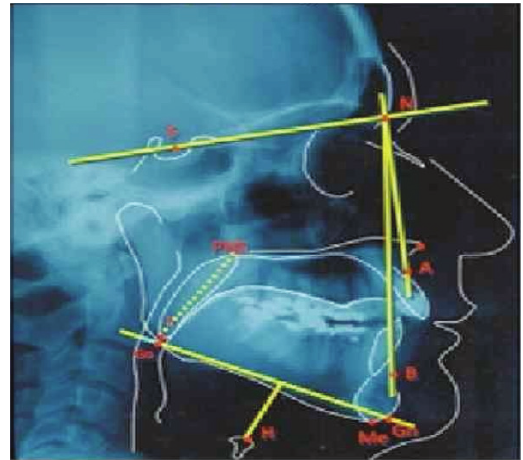
Figure 1 Teleradiography. Cephalometric analysis, lateral view, with barium contrast at the base of the